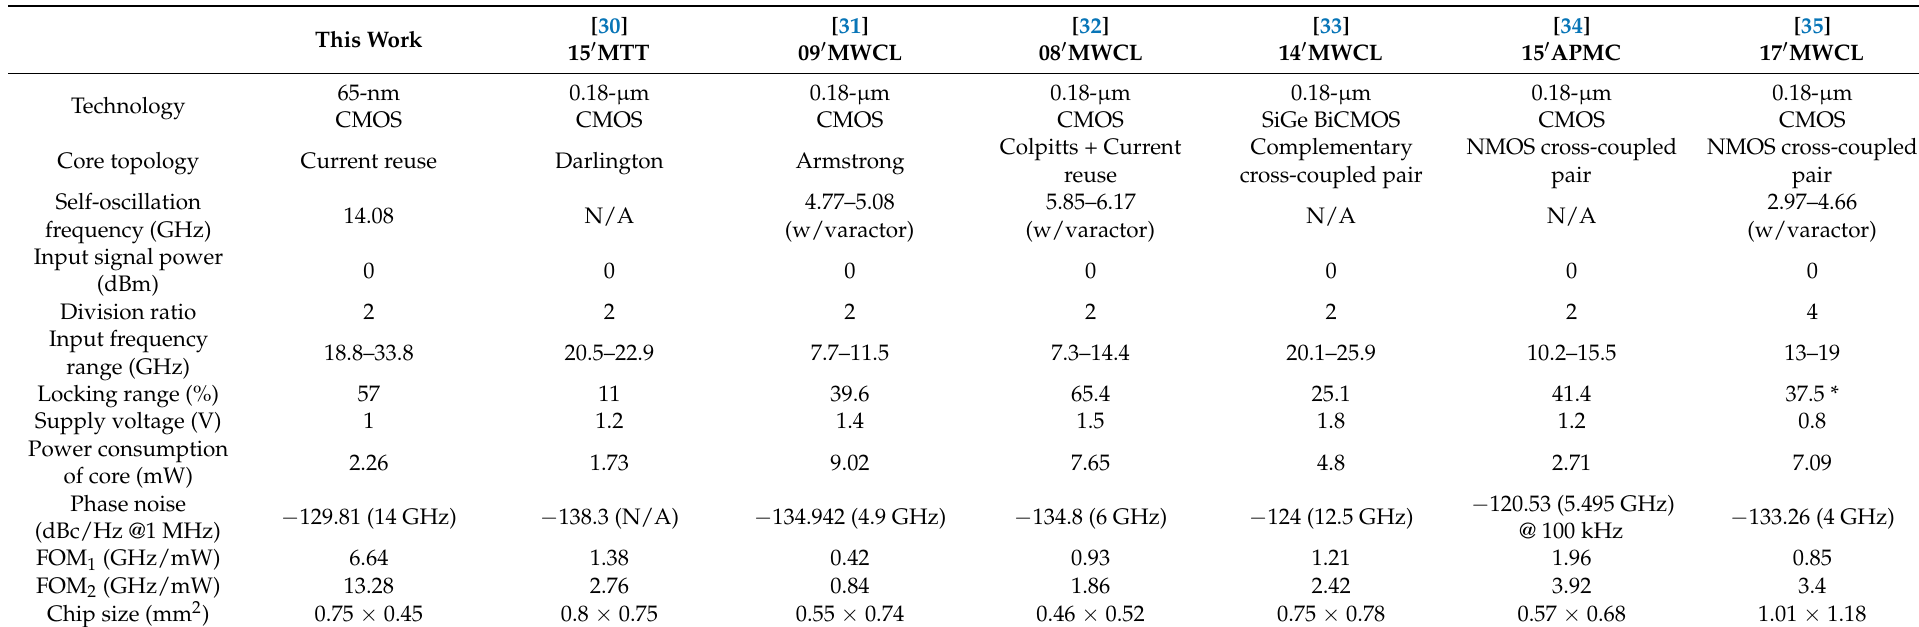
Table 2. Performance comparison of different core